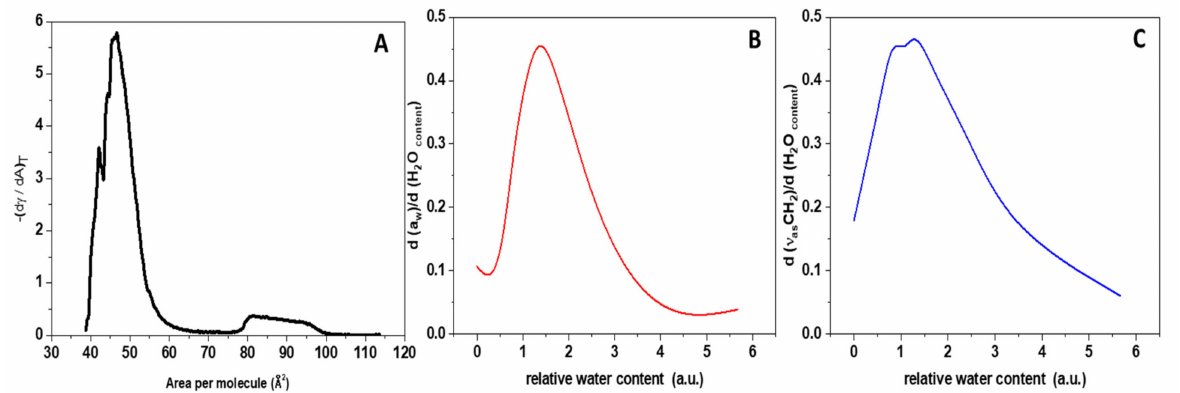
Figure 5. ( A ) Derivative of the surface tension vs. area per molecule curve below T c ; ( B ) Derivative of the a w vs. water content curve below T c ; ( C ) Derivative of the CH 2 frequency vs. water content curve below T